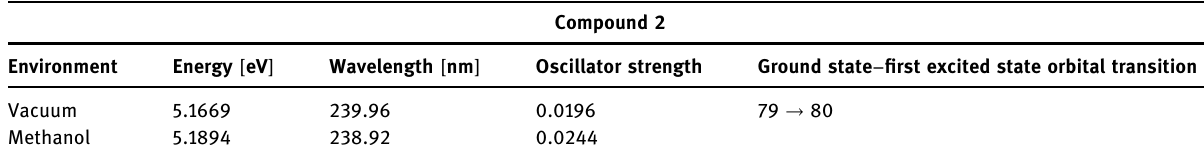
Table 6: First excited states of the fl uconazole 2 computed using LR TDDFT approach in vacuum or in methanol; B3LYP/6 - 311 ++ G ( 2d,3p ) // B3LYP/6 - 31G ( d,p ) level of theory